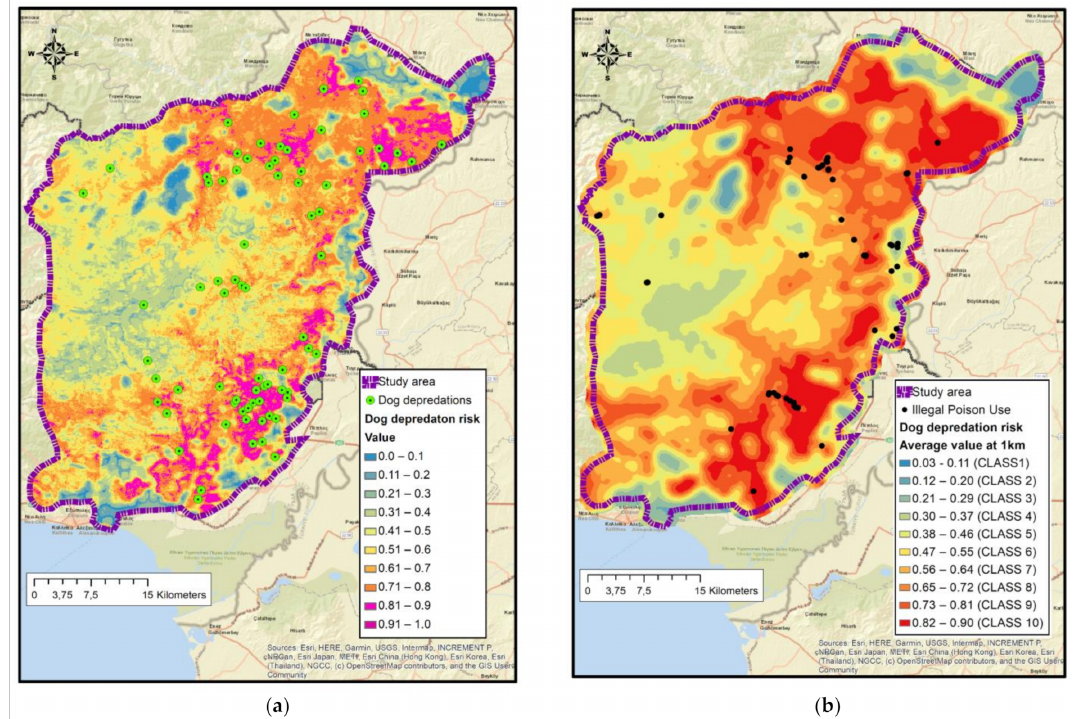
Figure 4. ( a ) Dog depredation events and risk map in the Dadia-Lefkimi-Soufli Forest National Park and adjacent areas. ( b ) Distribution of poisoning incidents (2012–2020) overlayed over the dog depredation risk predictive map averaged within a radius of 1 km (right). Classifications are in 10 equally sized